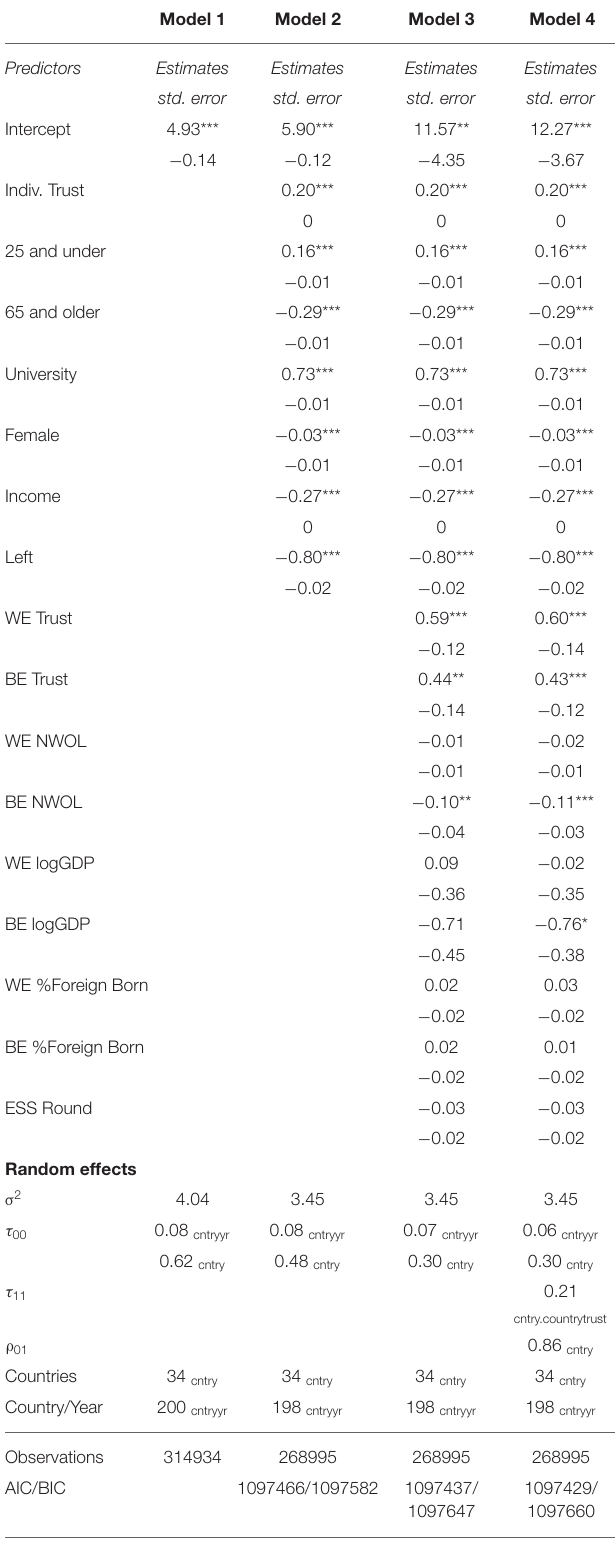
TABLE 1 | Multi-level regression